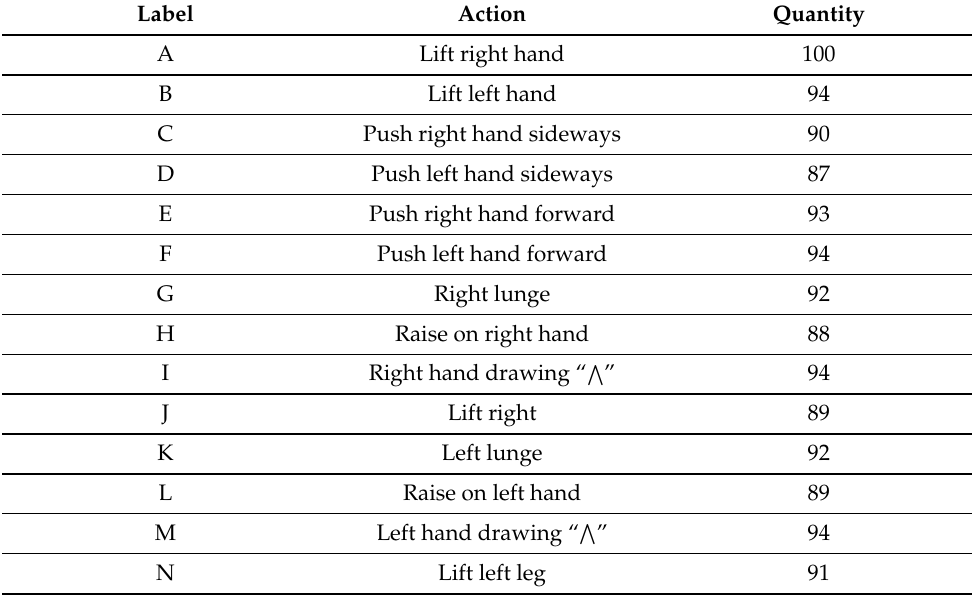
Table 1. Dataset